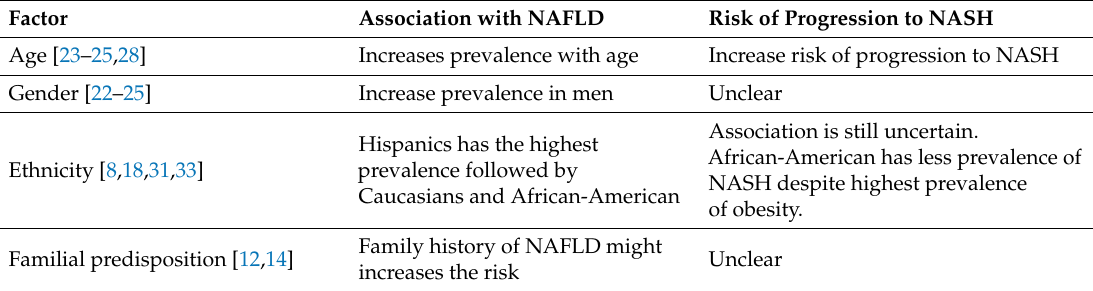
Table 2. Nonmodifiable risk factors for